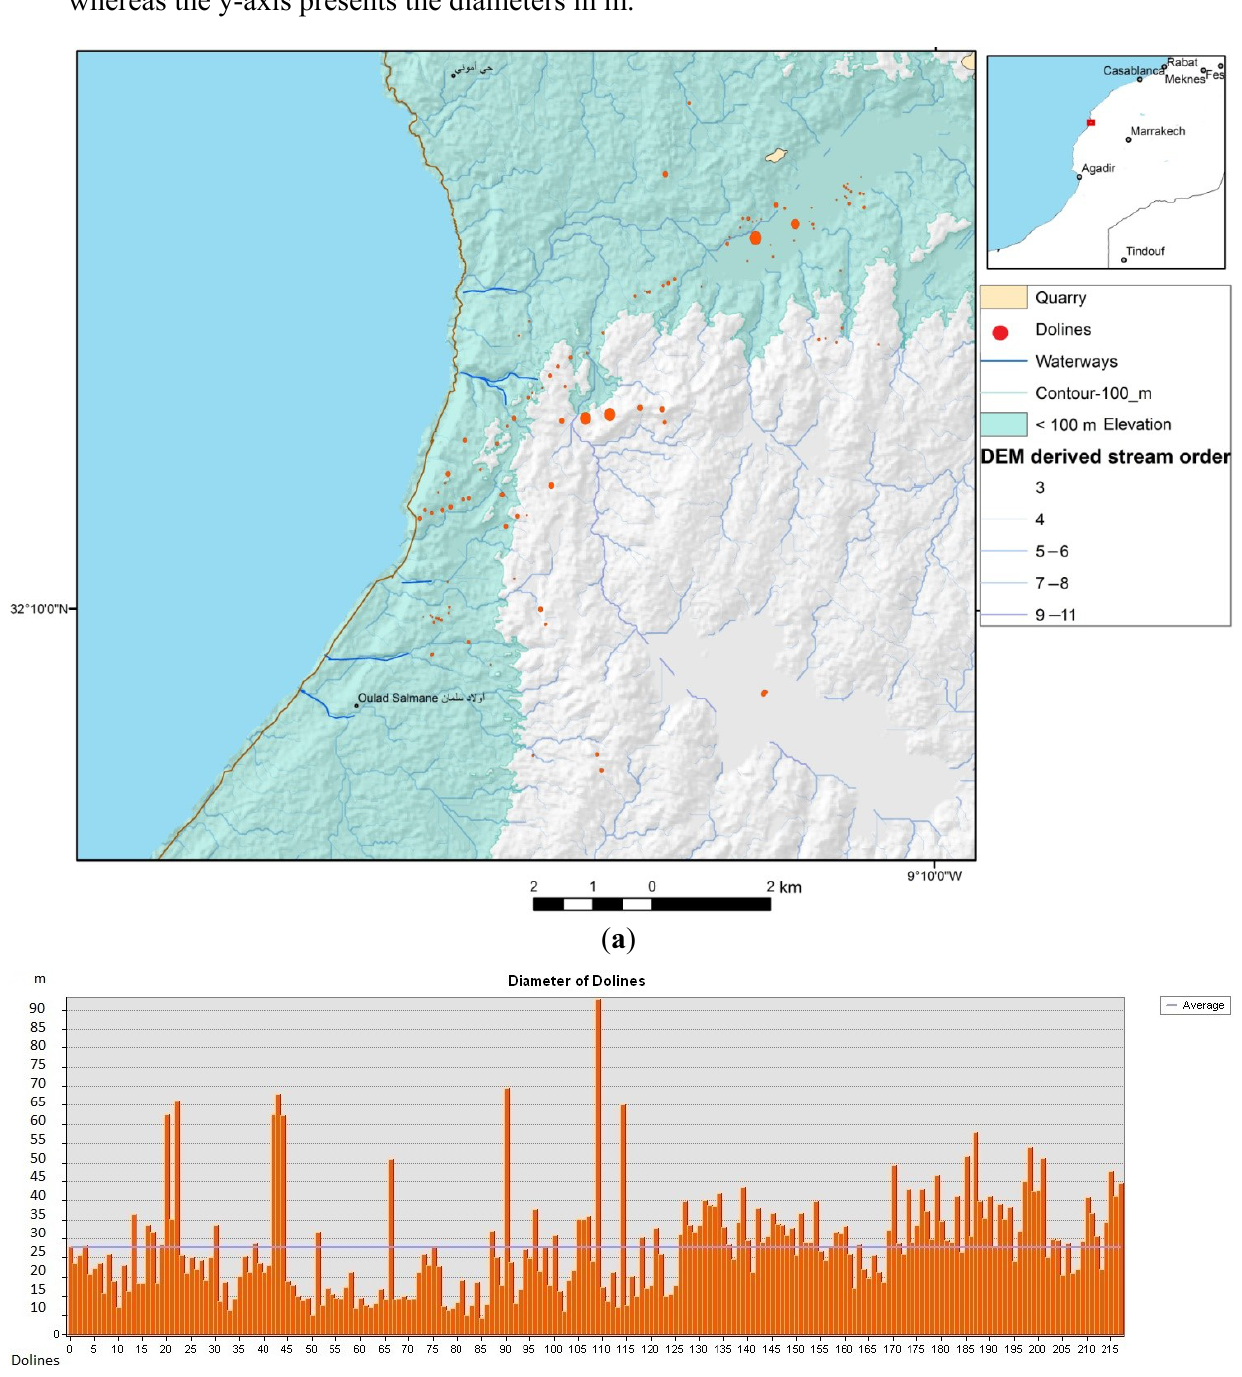
Figure 17. ( a ) Sizes of visually-digitized dolines and circular features assumed to be dolines based on satellite images and ( b ) diagram of the diameter sizes of dolines. Each segment and number on the x-axis of the histogram presents one, single, digitized doline, whereas the y-axis presents the diameters in